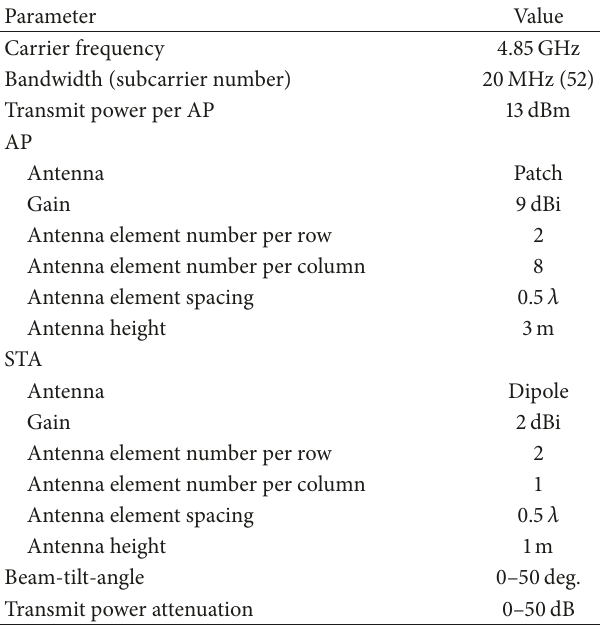
Table 1: Measurement